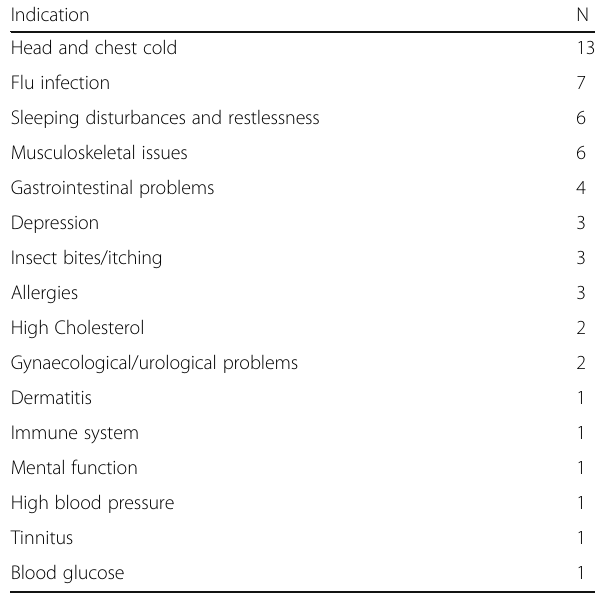
Table 3 Absolute frequencies of indications mentioned for using HM (multiple answers were